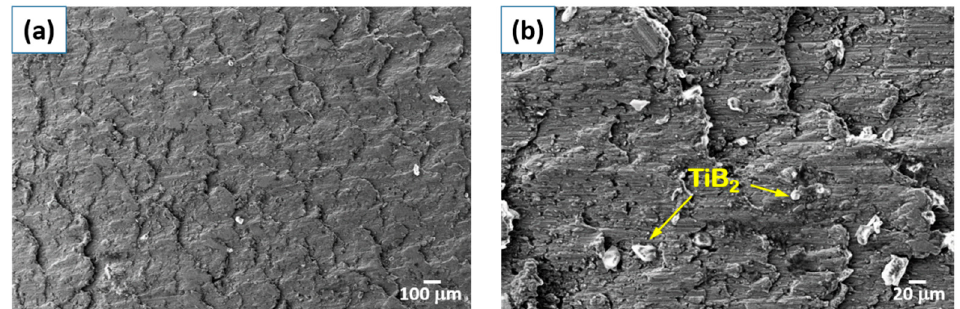
Figure 11. SEM micrographs of machined composite: ( a ) typical machined surface at 106×; ( b ) visible grooves of metal matrix and TiB 2 particles at 500×.